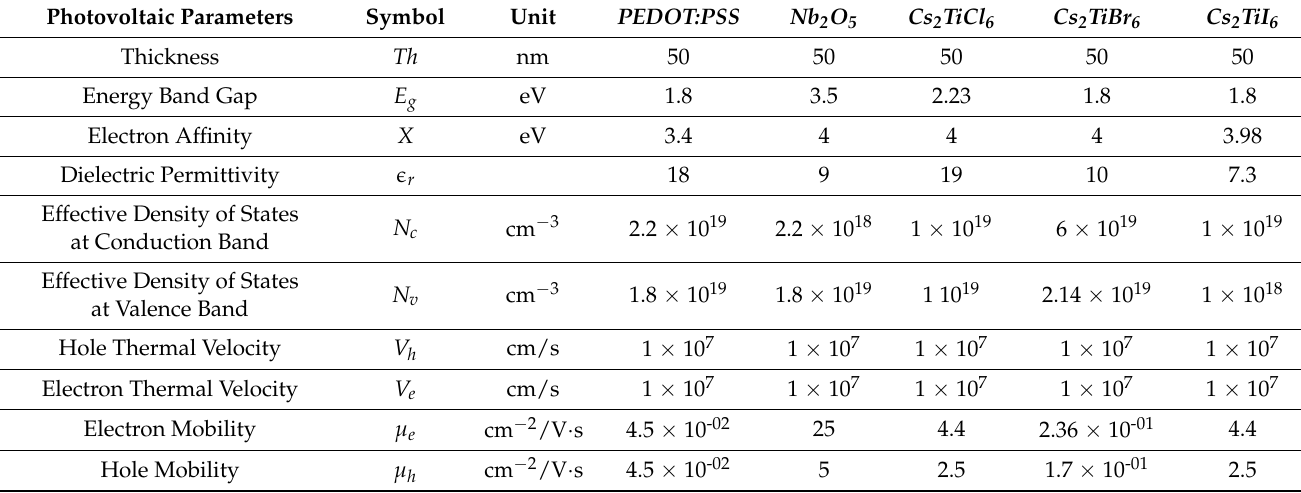
Table 1. The physical and material parameters for active perovskite layers, a hole-transport layer, and an electron-transport layer are considered in the simulation by SCAPS